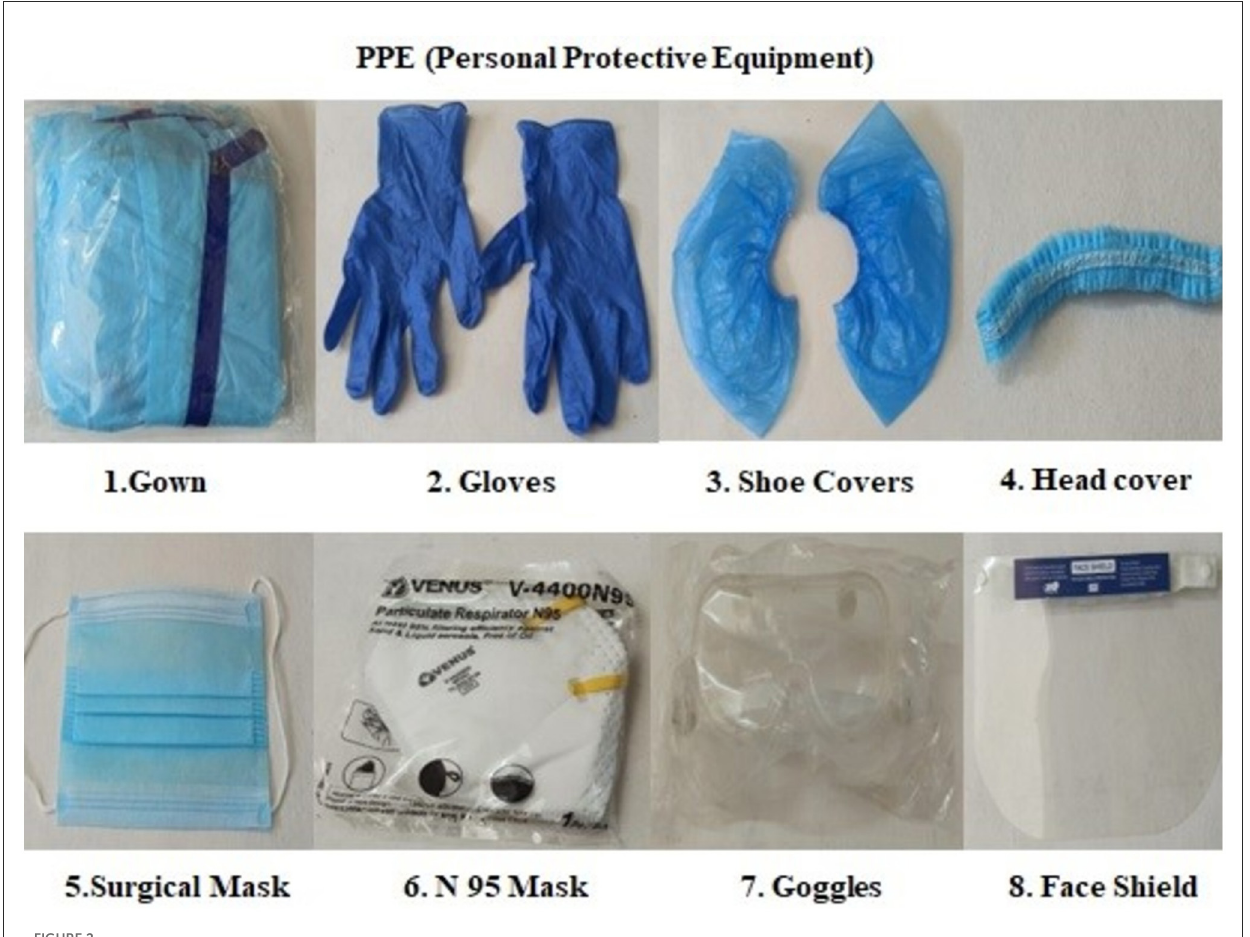
FIGURE2 Personal protective